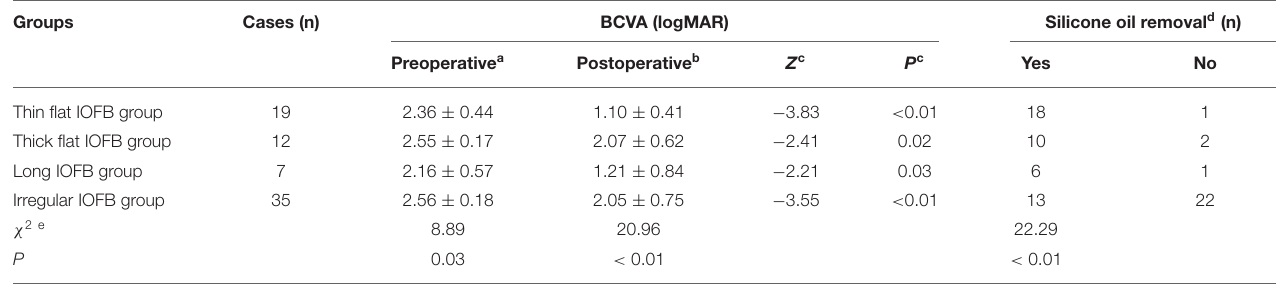
TABLE 3 | Preoperative BCVA, postoperative BCVA, and rate of silicone oil removal in different IOFB shape groups. Groups